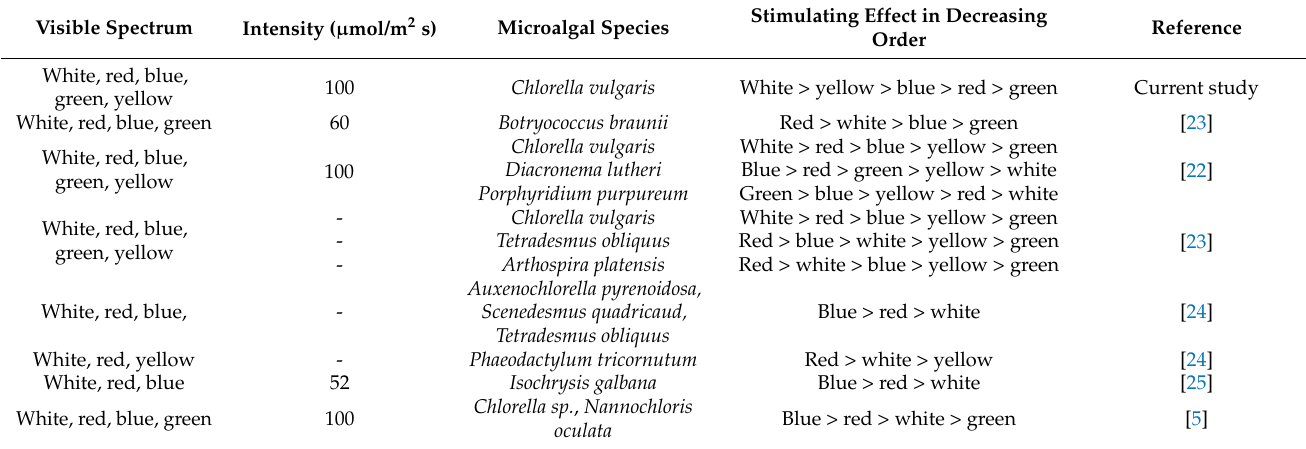
Table 1. Microalgal growth responses to various visible spectra of